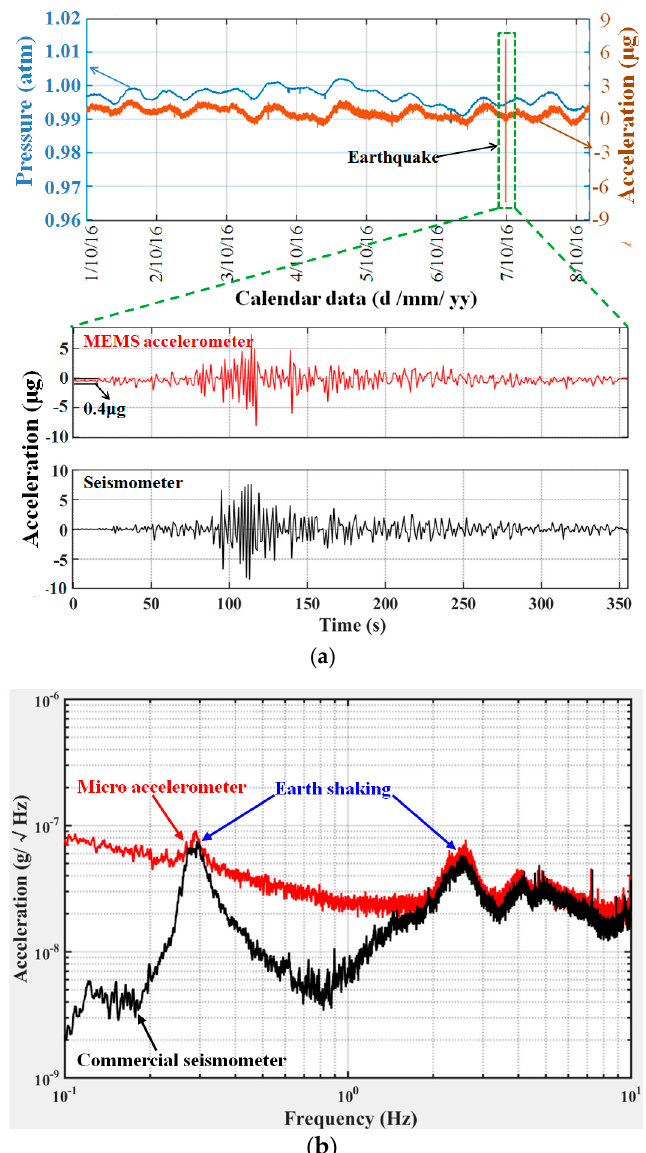
Figure 11. Performance of the micro accelerometer using the optimized area-changed transducer. ( a ) Static output of the area-changed capacitive micro accelerometer for eight days. A Ms5.9 earthquake that occurred in Taiwan at 23:51 06/10/2016 (UTC-8) was detected. The details of the earthquake detected by our micro accelerometer and the commercial seismometer show good agreement. ( b ) Noise-limited resolution of the optimized accelerometer.